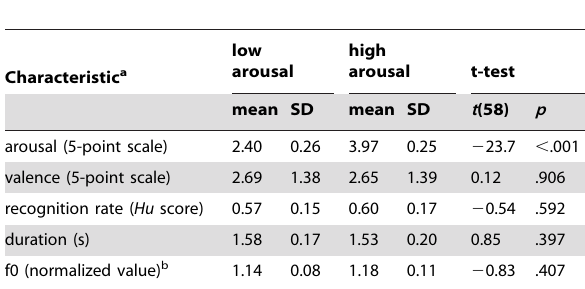
Table 1. Characteristics of low- and high-arousal speech